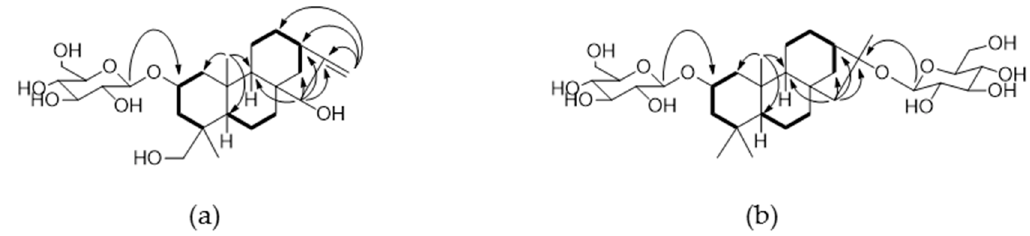
Figure 2. Key COSY (bold line) and HMBC (plain arrow) correlations of compounds 4 ( a ) and 10 ( b ).